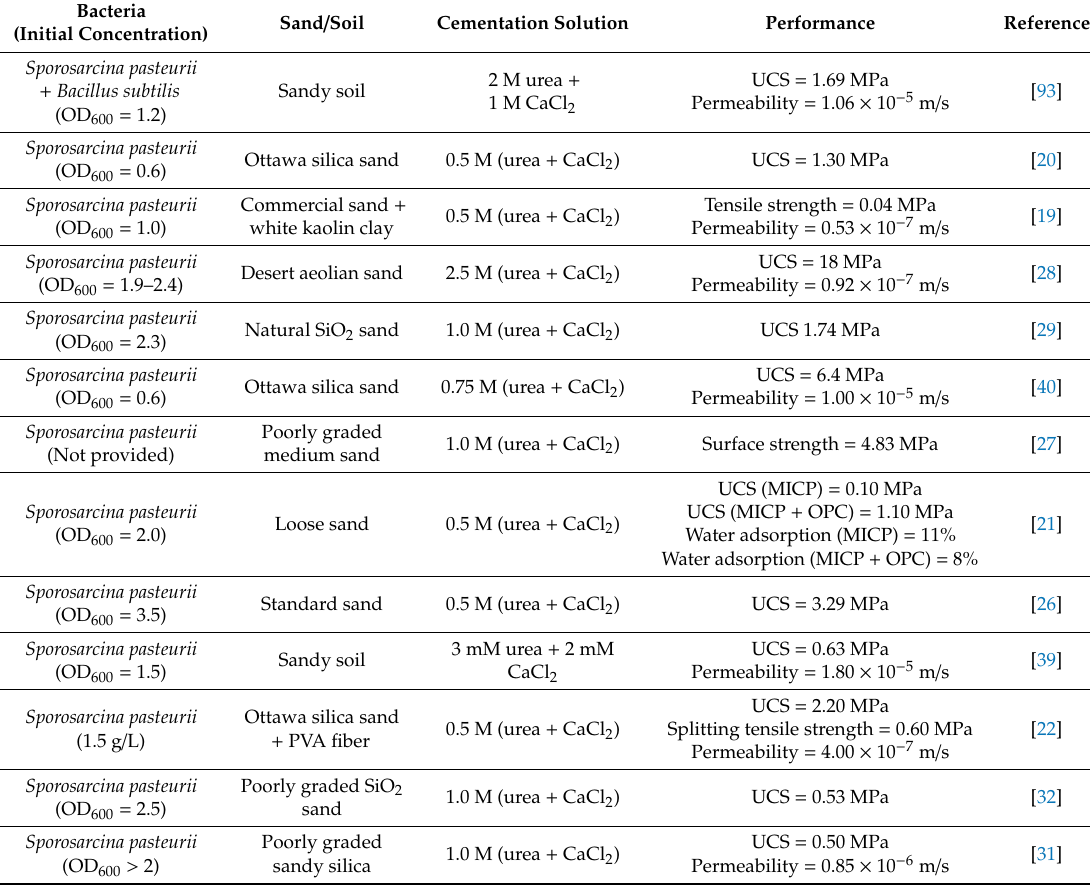
Table 6. Biocementation of sand and soil through